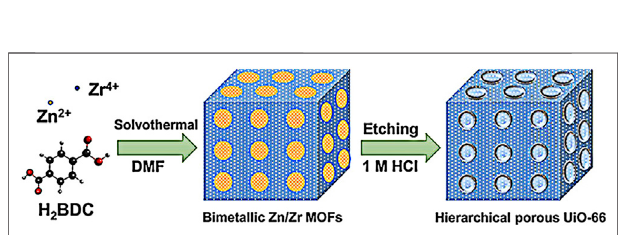
FIGURE 5 | Schematic illustration of the synthesis of UiO-66. Reprinted with permission from Gao et al. (2017). Copyright 2017, American Chemical